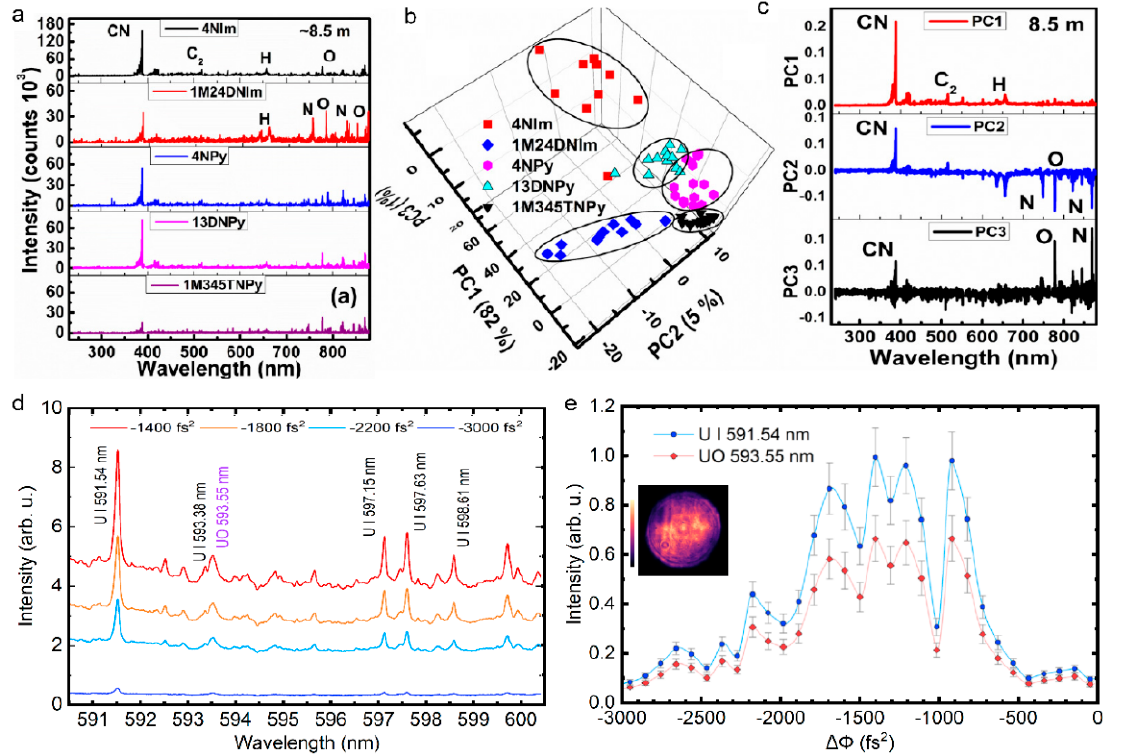
Figure 22. ( a ) Typical FIPS spectra of explosive molecules (nitroimidazoles and nitropyrazoles) that were obtained at 8.5 m away; ( b ) PC scores plot and ( c ) first three PCs for the processed LIBS spectra of explosives (nitroimidazoles and nitropyrazoles) that were obtained at 8.5 m [330]. ( d ) Typical uranium emission spectra for various GDD values of the incident laser pulse; ( e ) intensity of atomic (U I 591.54 nm) line and molecular (UO 593.55 nm) spectral band for various applied quadratic phases to incident laser pulse [345].